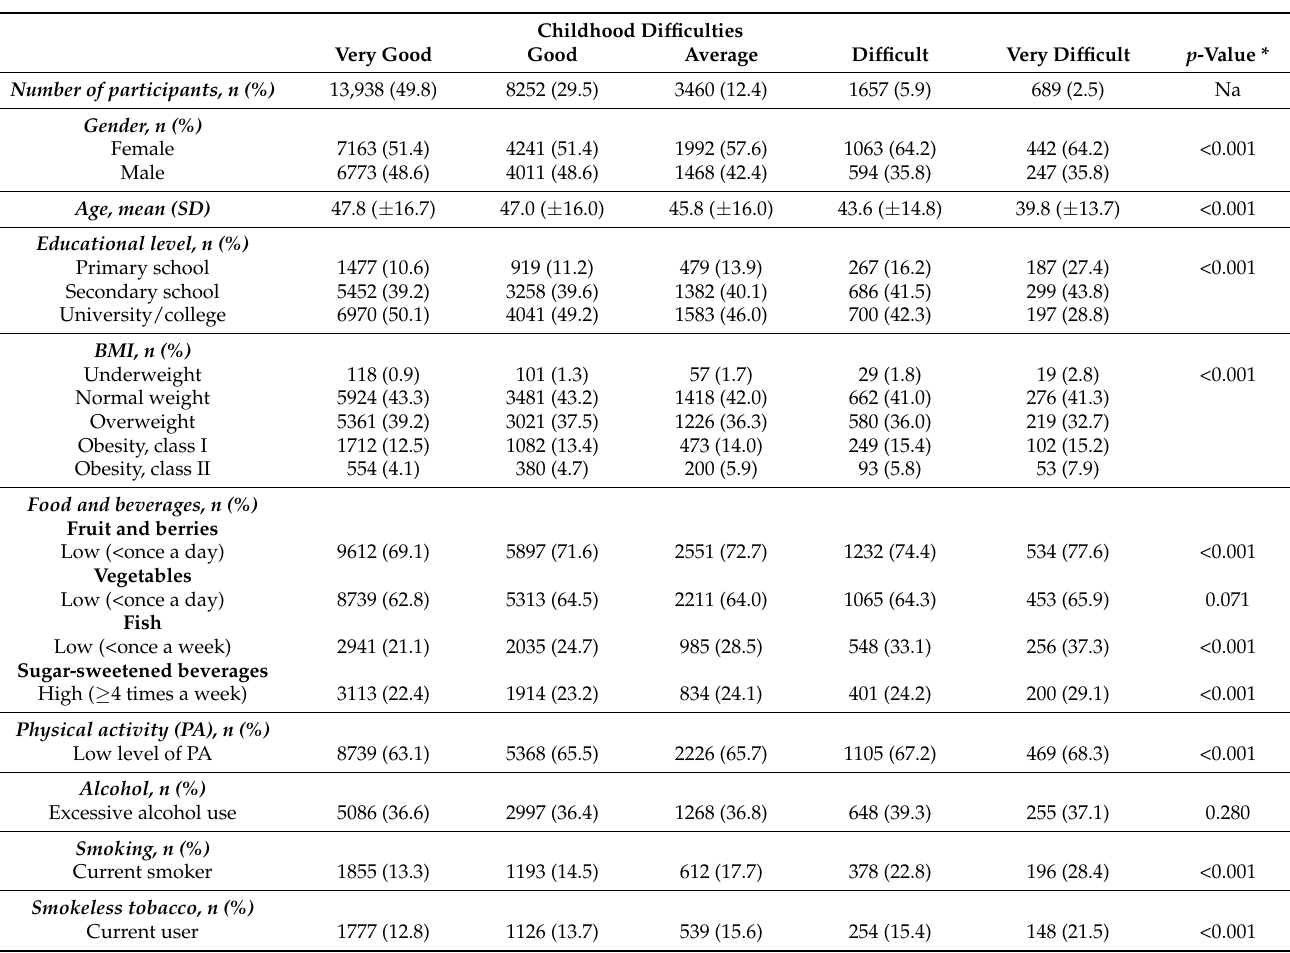
Table 2. Characteristics of participants according to self-perceived childhood difficulties. Childhood Difficulties Very Good Good Average Difficult Very Difficult p -Value *